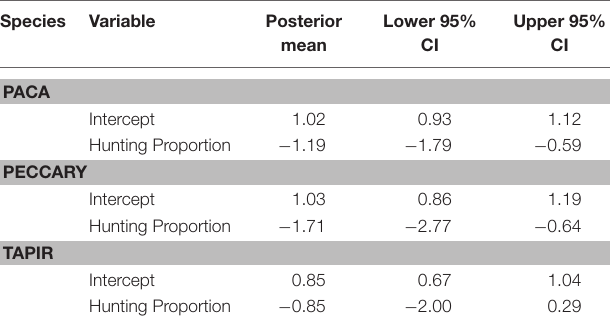
TABLE 6 | We report the posterior mean and the 95% credible interval for the three animal population